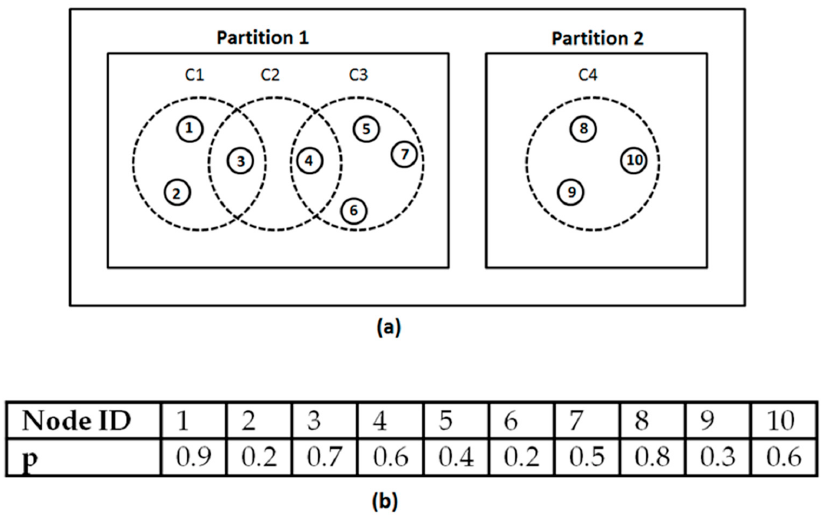
Figure 2. ( a ) Difference between cluster and partition , ( b ) Example values of p .